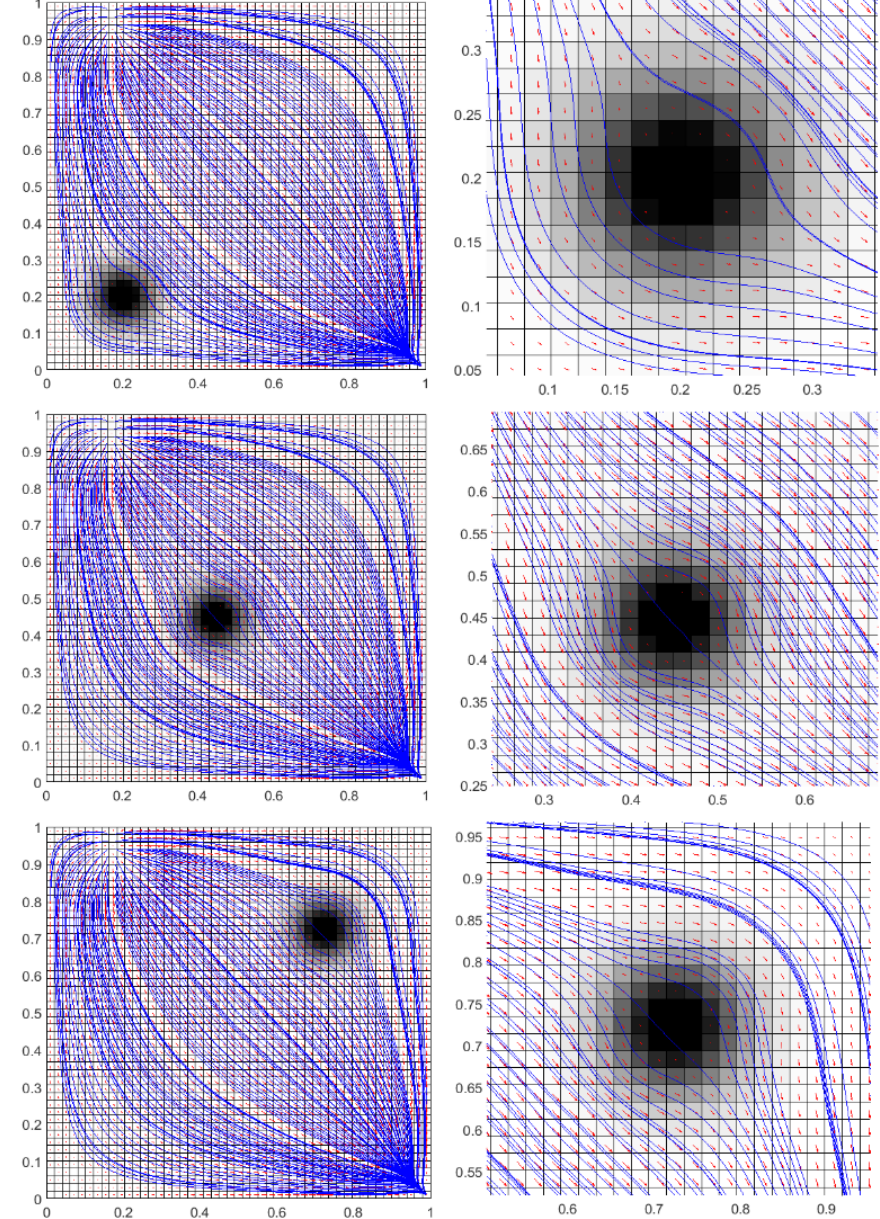
Figure 1. PGD reconstruction to obtain the set of path planning trajectories in a dynamic environment where the black hole represents a dynamic